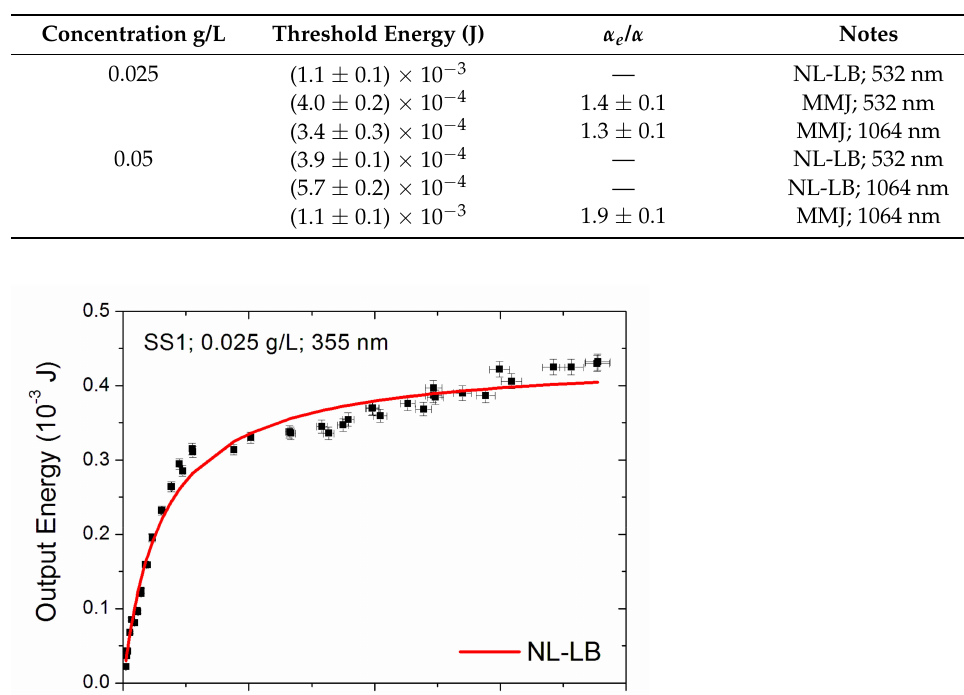
Table 2. Energy Threshold values obtained from fitting with both models and α e / α ratio obtained from the MMJ model.